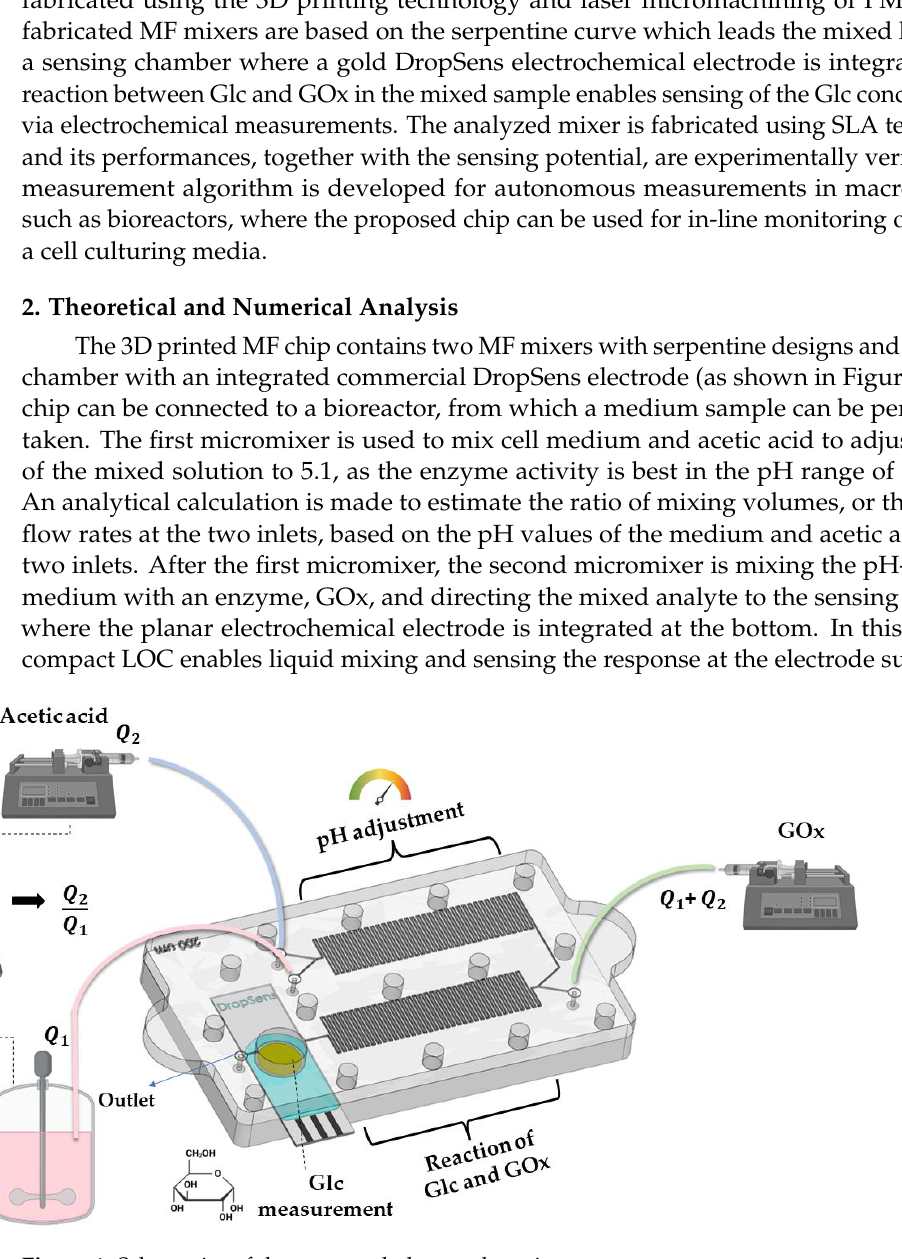
Figure 1. Schematics of the proposed glucose detection concept.